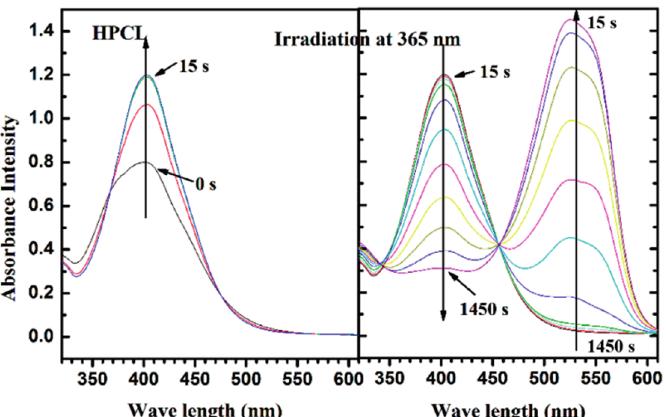
Figure 12. The UV-vis absorption changes of the hyperbranched poly( ε -caprolactone) (HPCL, M n GPC = 25,500 g/mol, M w / M n = 2.38) during the irradiation with 365 nm UV light in chloroform solution (The concentration of azobenzene moieties is 5.00 × 10 − 5 M at room temperature). The arrows means that the time go on and the absorbance intensity decreased or increased.